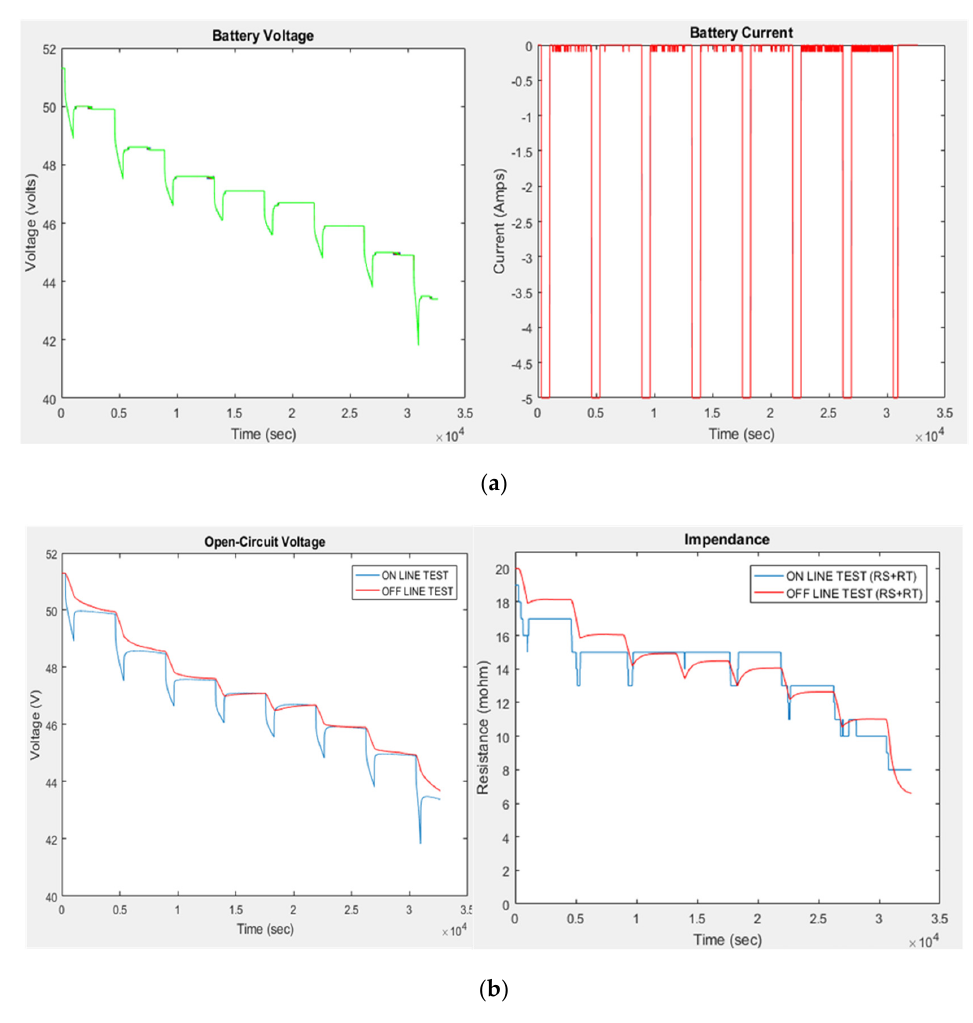
Figure 10. ( a ) Voltage drop and discharge current; ( b ) comparison of online estimating open-circuit voltage (OCV) and internal resistances (IRs) with the o ffl ine numerical